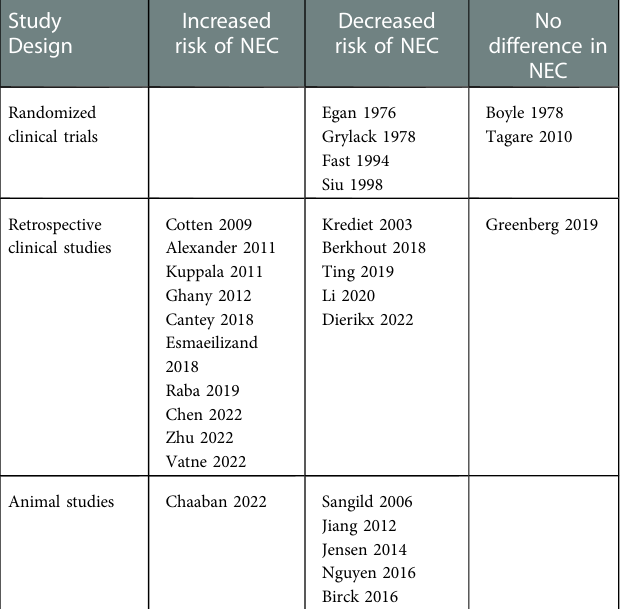
TABLE 4 Summary of human and animal studies regarding early antibiotics and NEC. Study